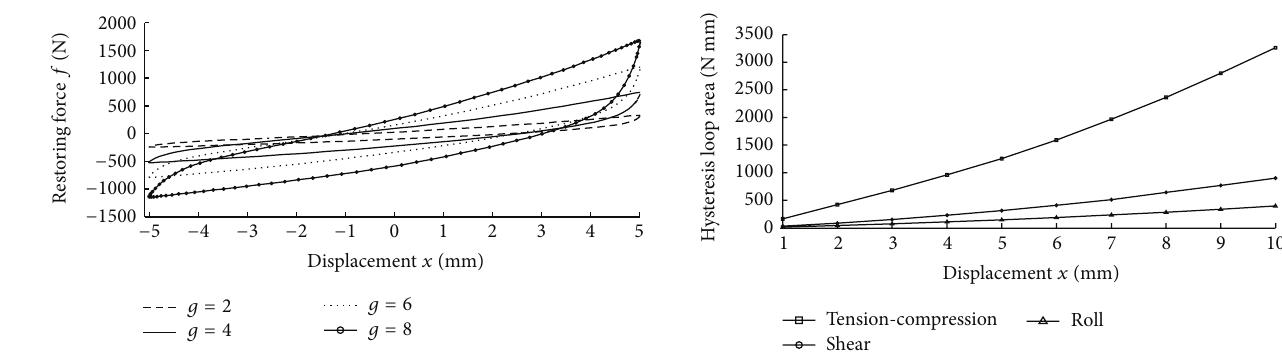
Figure 10: Hysteresis loop area versus loading amplitude.